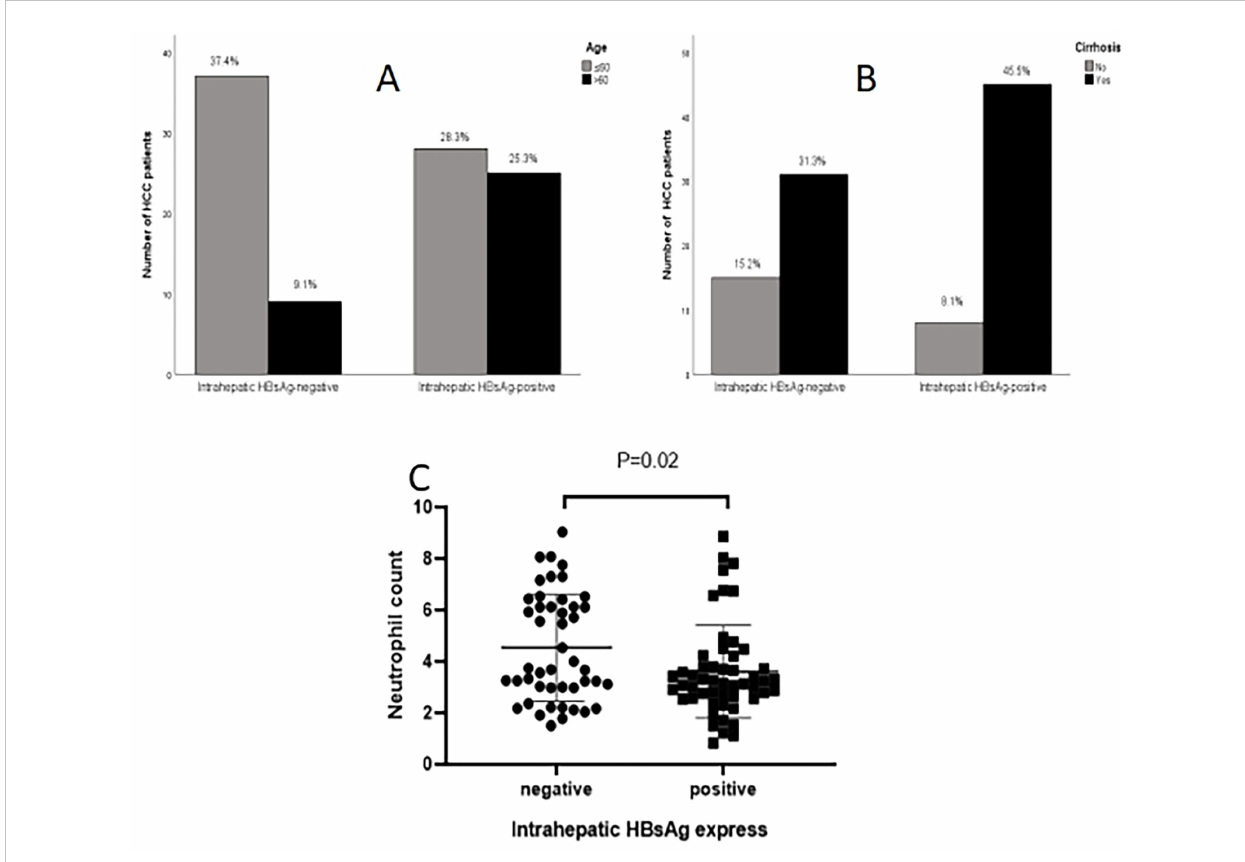
FIGURE 2 Comparison of clinical data based on intrahepatic HBsAg. (A) Age; (B) Cirrhosis; (C, D) neutrophil count.